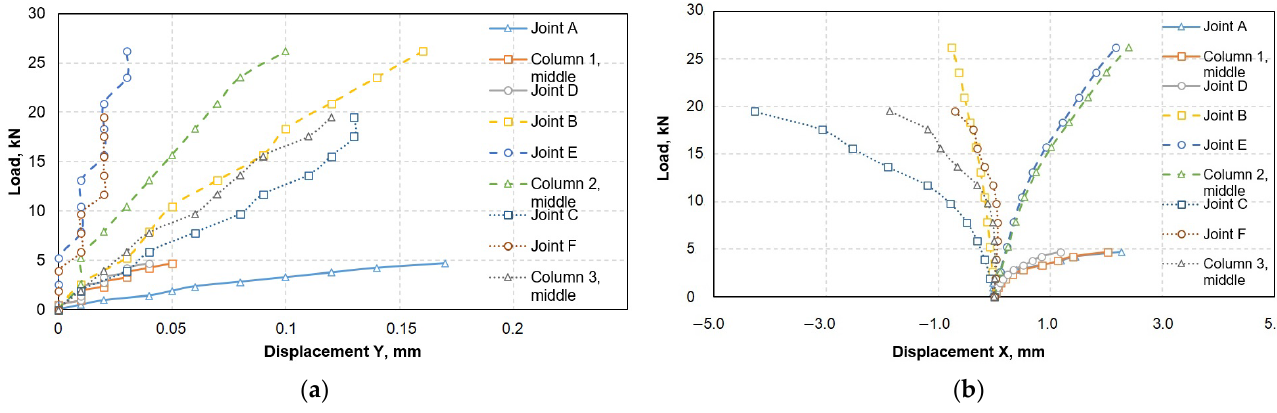
Figure 7. Horizontal displacement of the frame joints in the X ( a ) and Y ( b ) directions.